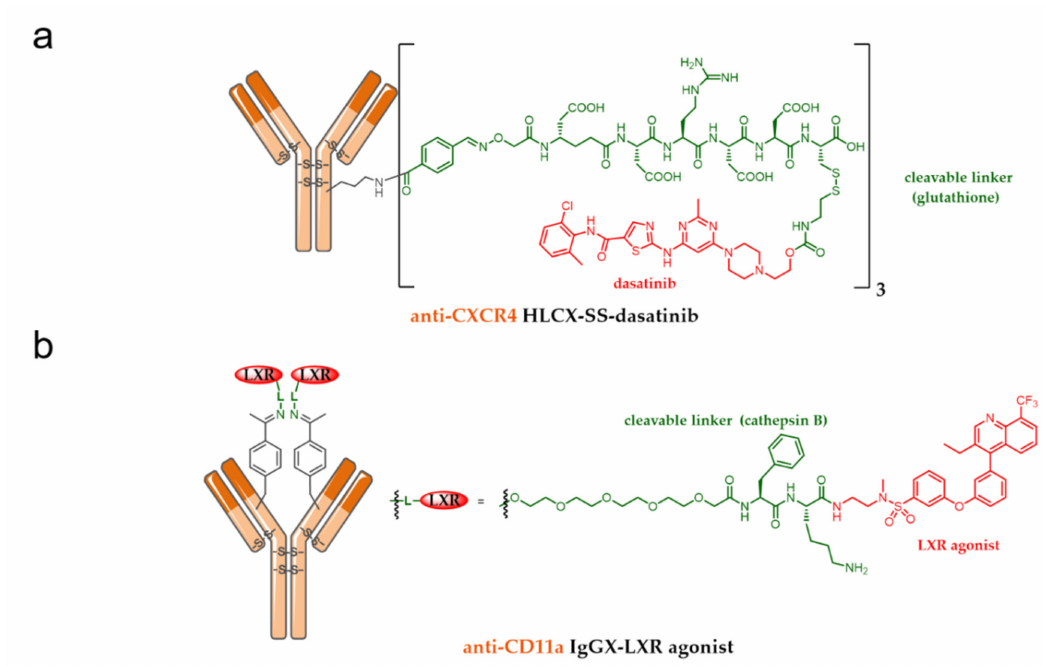
Figure 18. ( a ) Formula of an ADC resulting from the stochastic conjugation of dasatinib onto an optimized anti-CXCR4 mAb (HLCX) through a gluthathione sensitive linker, with an average DAR of 3. ( b ) Formula of an ADC resulting from the site-specific conjugation of a LXR agonist onto an anti-CD11a mutated mAb, with a homogeneous DAR of